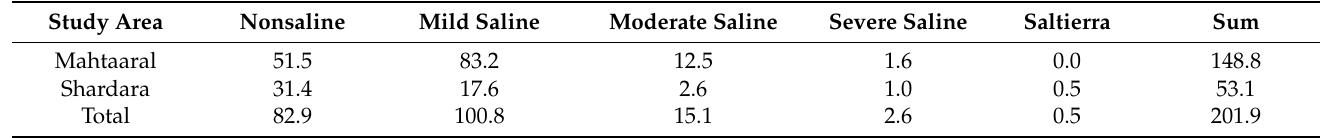
Figure 4. Spatial distribution of salinity, major salt ions, and Cl − /SO 42 − equivalent ratio of cropland in the Mahtaaral district. Table 4. Distribution area of different degrees of saline